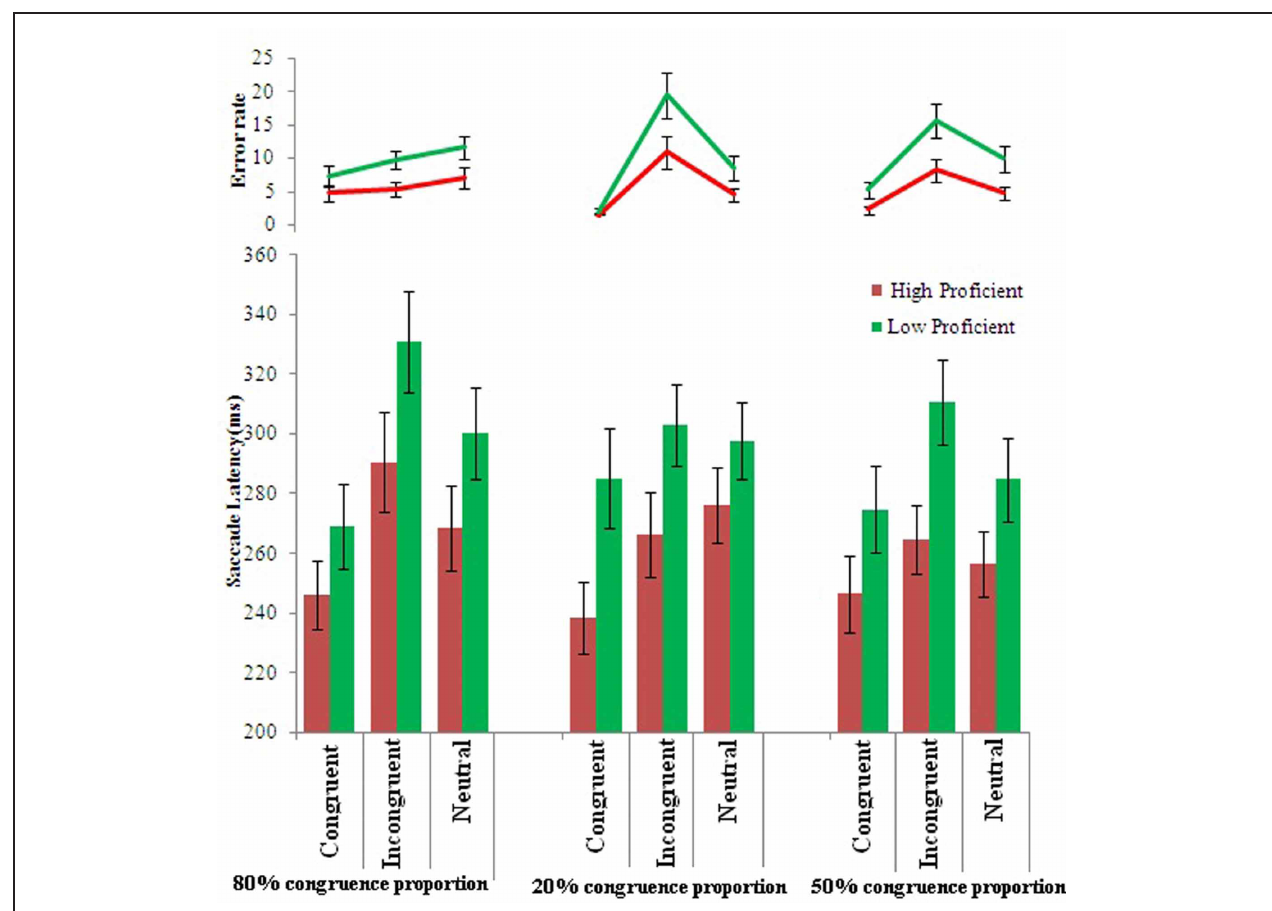
FIGURE 2 | Mean saccade latency (ms) and error rates for high and low proficient bilinguals for the saccadic arrow Stroop task in different congruence proportion